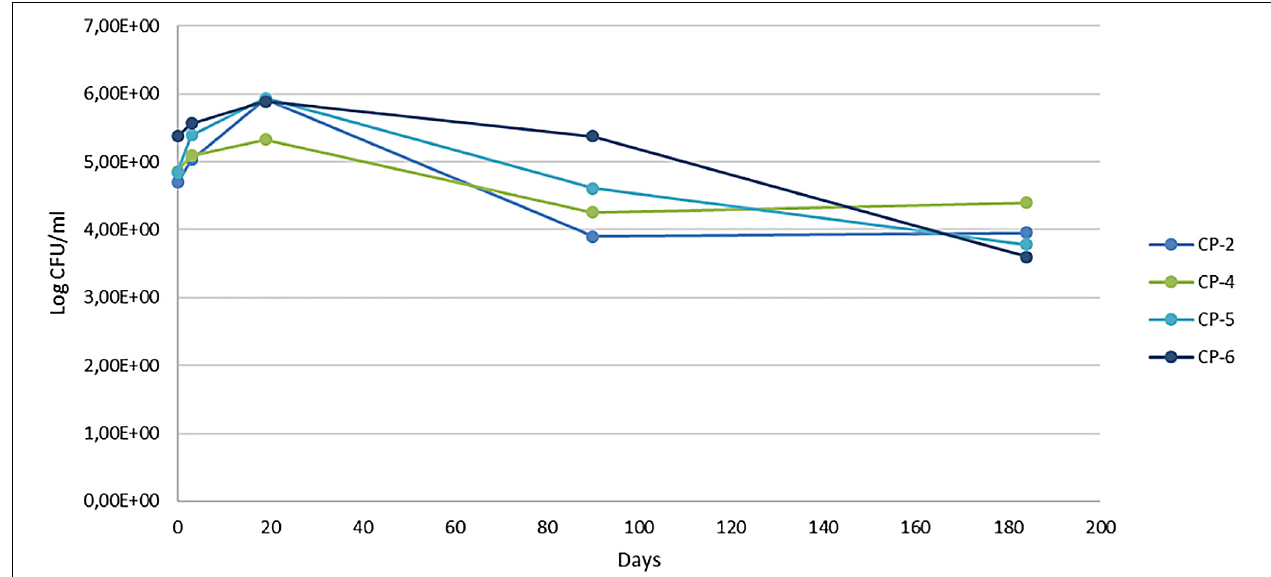
FIGURE 6 | Viable bacterial counts (colony forming units, CFU) per milliliter at different sampling times of the nZVI treatment (0, 3, 19, 90, and 184